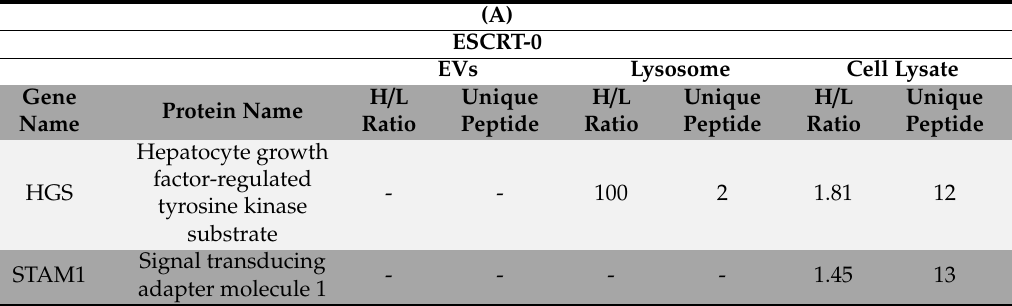
Table 2. H / L ratio analysis of the ESCRT machinery. The ESCRT system consists of 4 protein